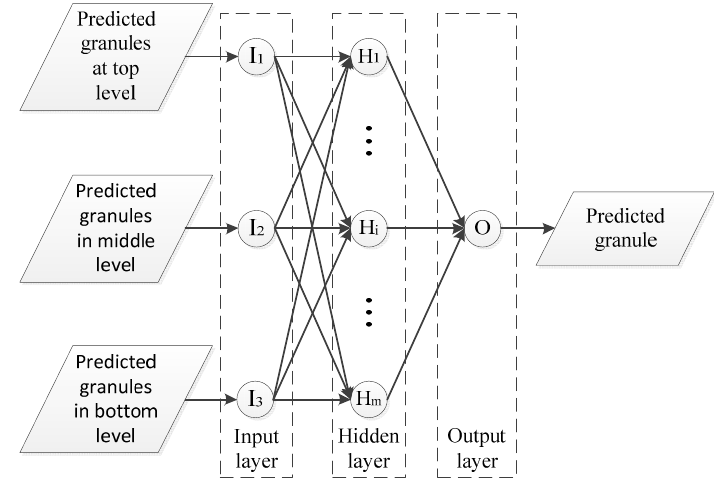
Figure 11. Topological structure of the synthesized ANN.